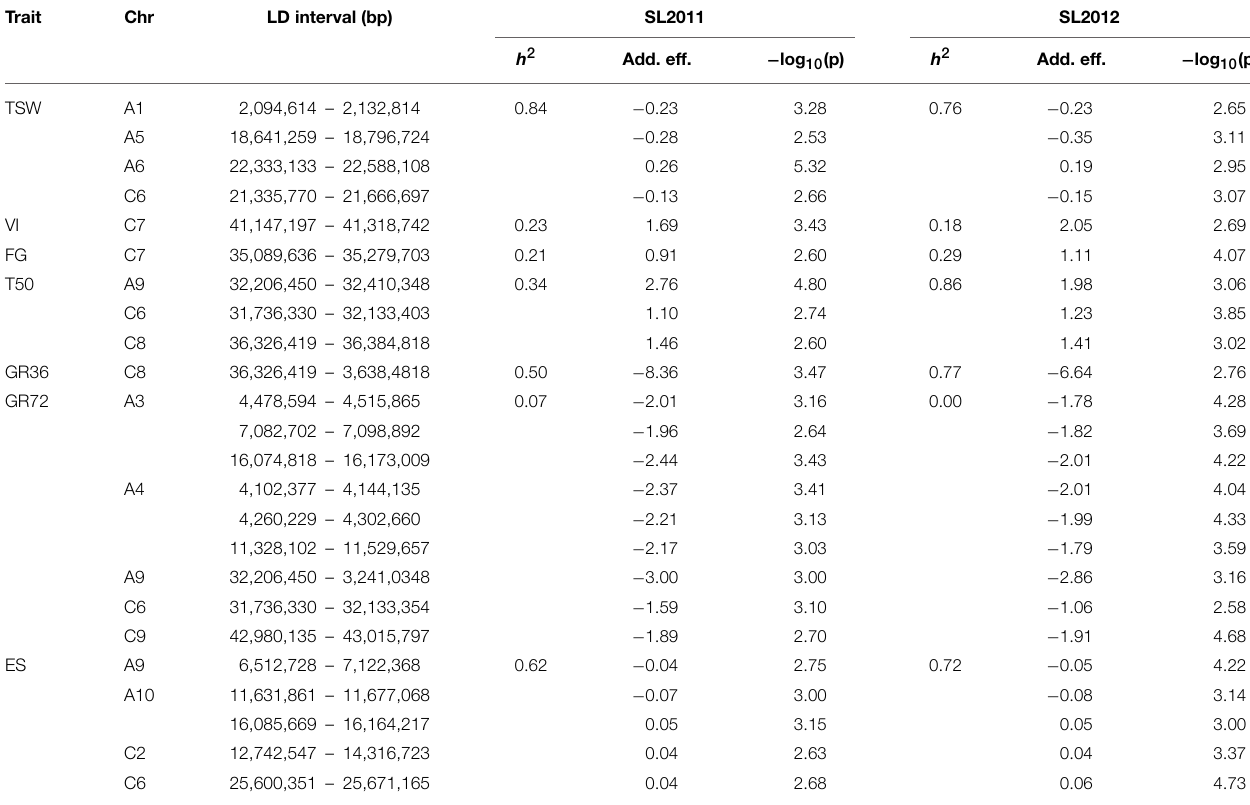
TABLE 3 | Intervals of linkage disequilibrium (LD) containing significant marker-trait associations for different traits related to germination performance in seeds of an oilseed rape diversity panel produced in Le Rheu, France in 2011 (SL2011) and Asendorf, Germany in 2012 (SL2012),